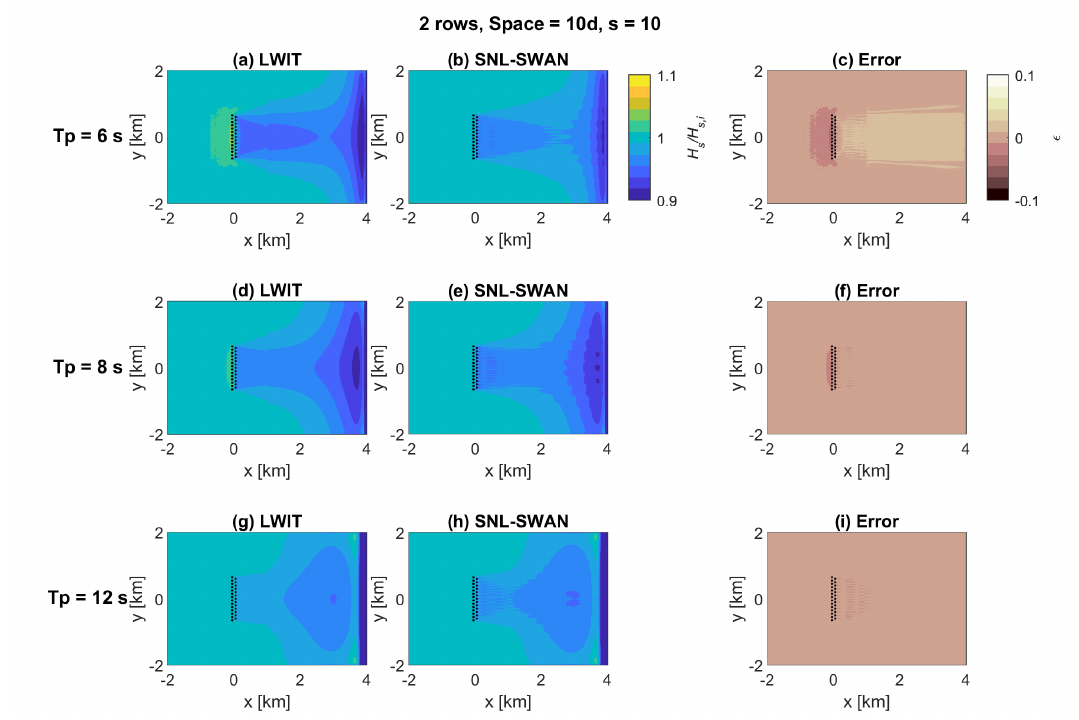
Figure 8. Wave fields, ˆ H s , and error (cid:101) for a particular array configuration at a particular directional spreading for the three wave periods under